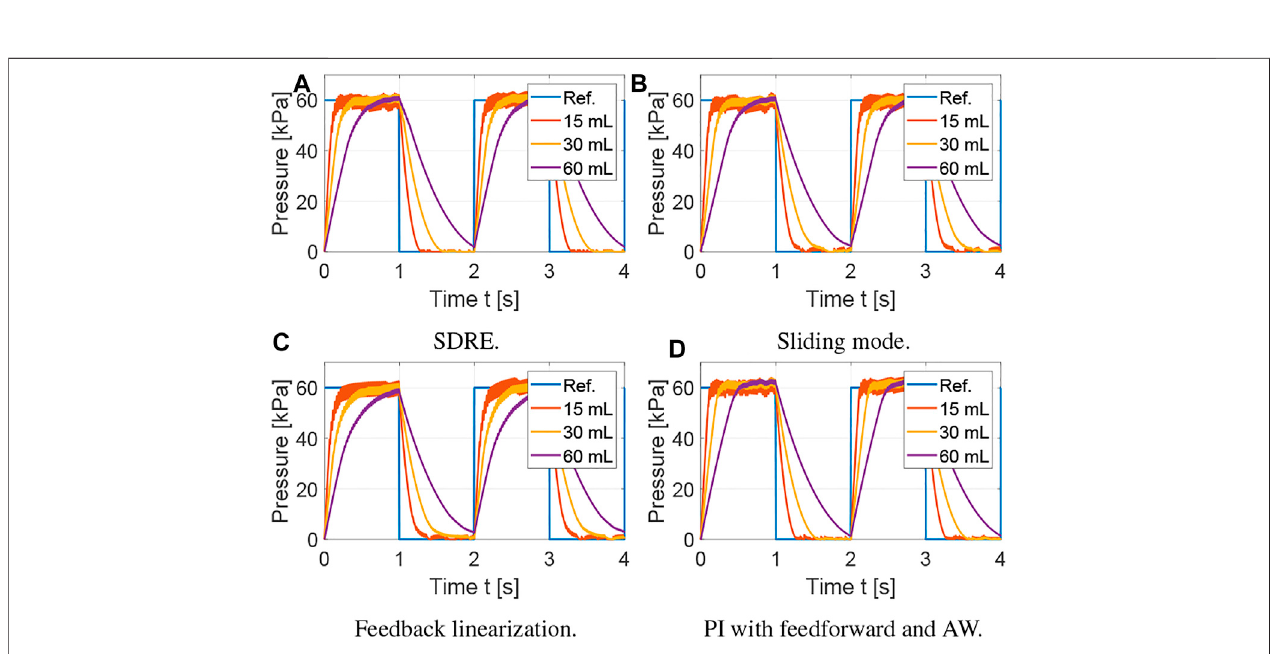
FIGURE5 | Evaluationof robustness of control strategies to variation in actuator volume. Foreach controller, the results are shown for three actuator volumes: 15, 30, and 60 ml. (A) SDRE. (B) Sliding mode. (C) Feedback linearization. (D) PI with feedforward and AW.